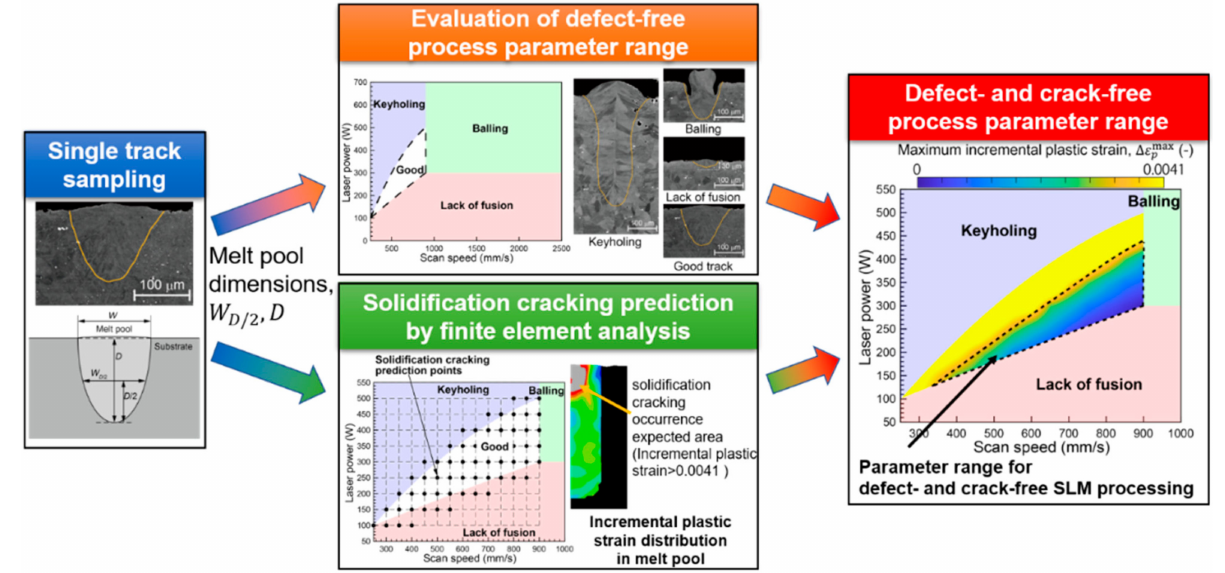
Figure 1. Outline of the proposed framework for determining appropriate selective laser melting (SLM) process parameter range considering defects and crack occurrence.